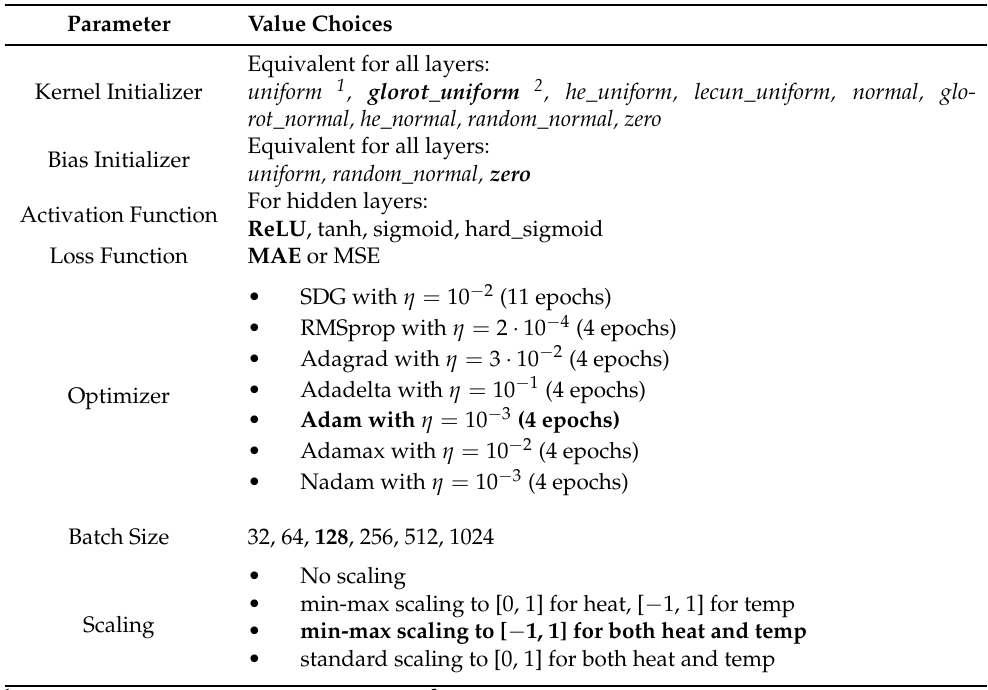
Table A2. Considered parameters and their value choices for internal parameter